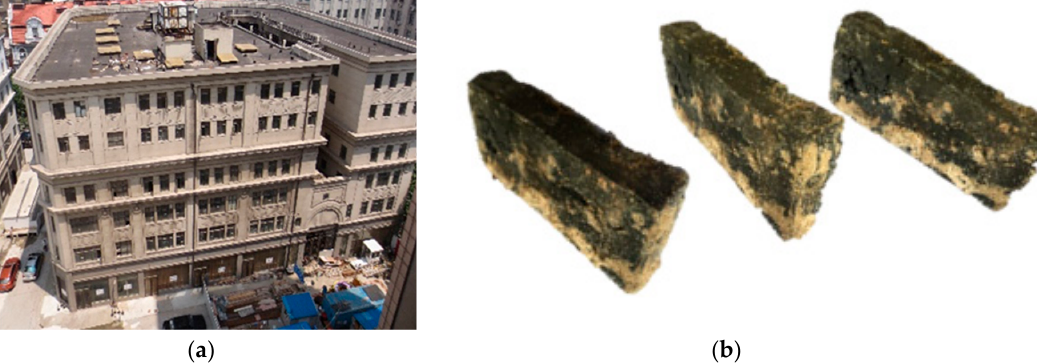
Figure 1. The historical building and bricks: ( a ) The historical building under rehabilitation; ( b ) the bricks sampled from the historical building. bricks sampled from the historical